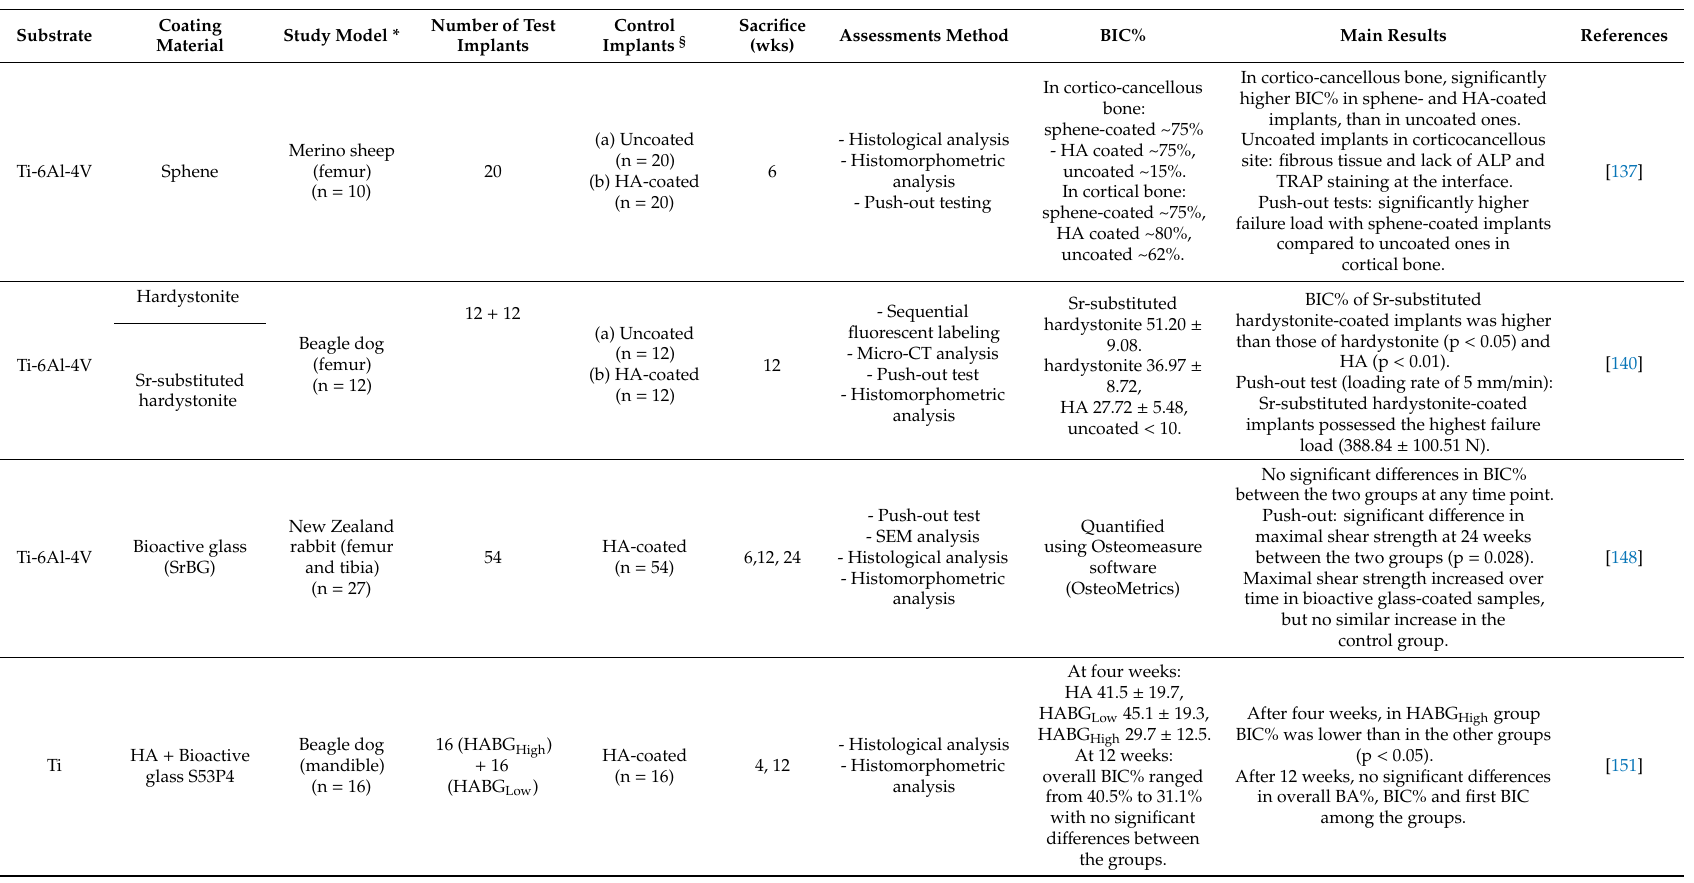
Table 8. Bioactive coatings: in vivo